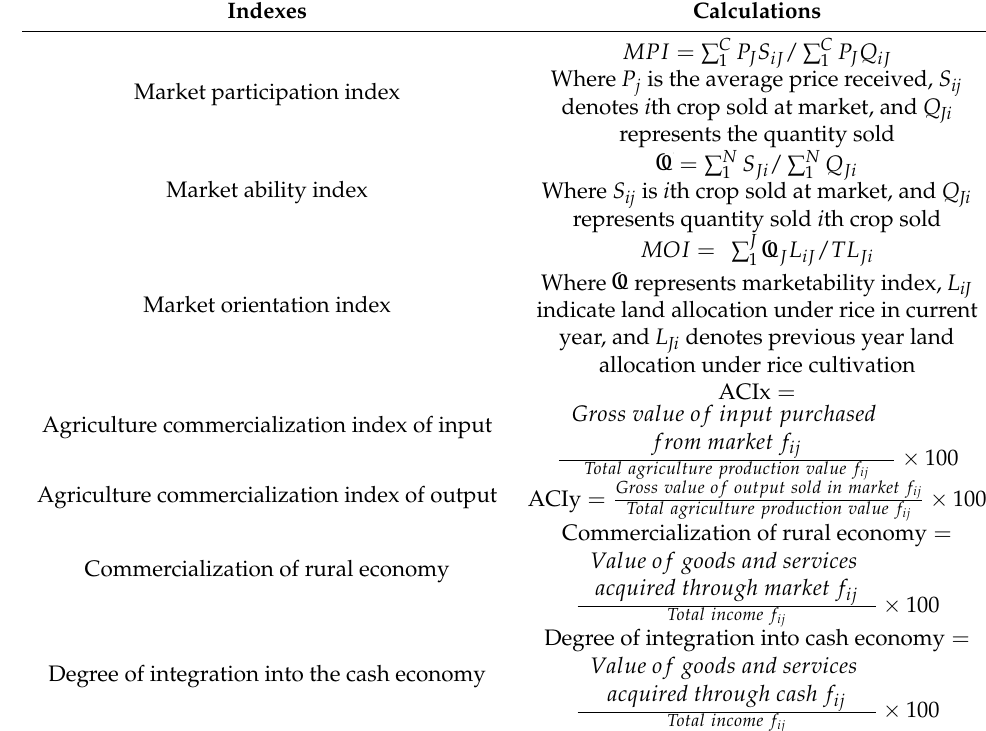
Table A1. Indexes used and their computations.